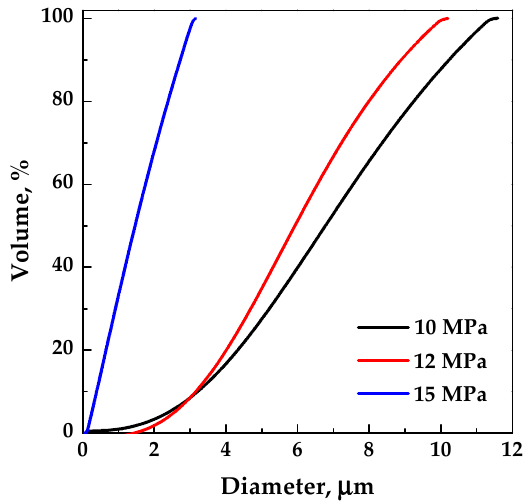
Figure 7. Volumetric cumulative PSDs of EUD/THEOP 20/1 particles precipitated from DMSO at 40 °C and 20 mg/mL; effect of the operating pressure.